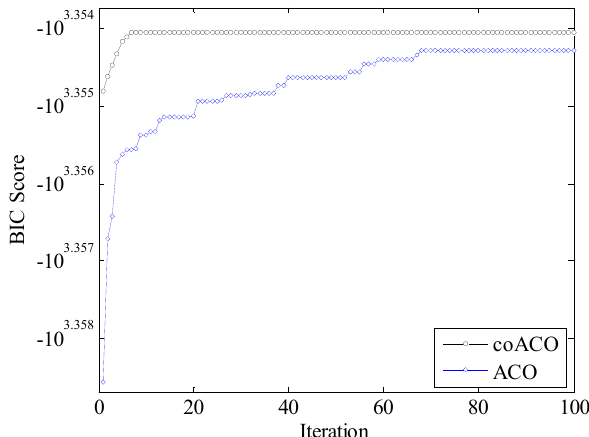
Figure 4. Evolution curves of the average Bayesian information criterion (BIC) score achieved by ACO and coACO on the ASIA dataset with n = 1000.